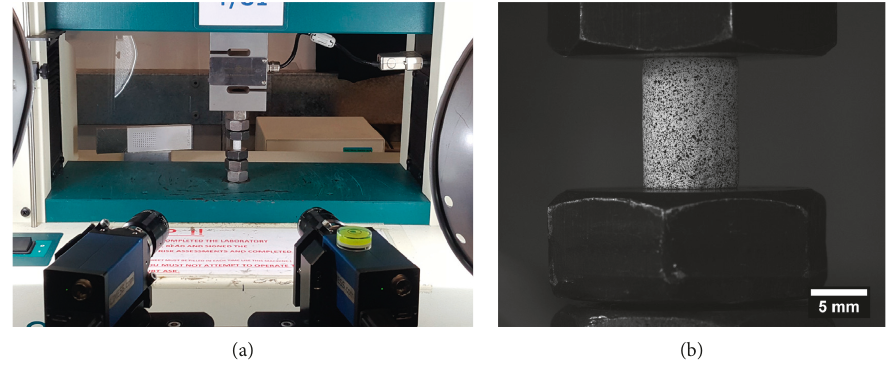
Figure 1: (a) DIC test setup; (b) porous sample in between two hardened steel